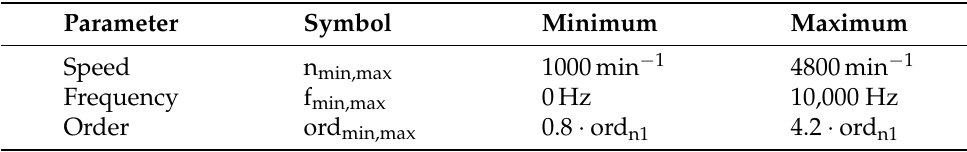
Table 5. Evaluation limits for the application force level L A,F